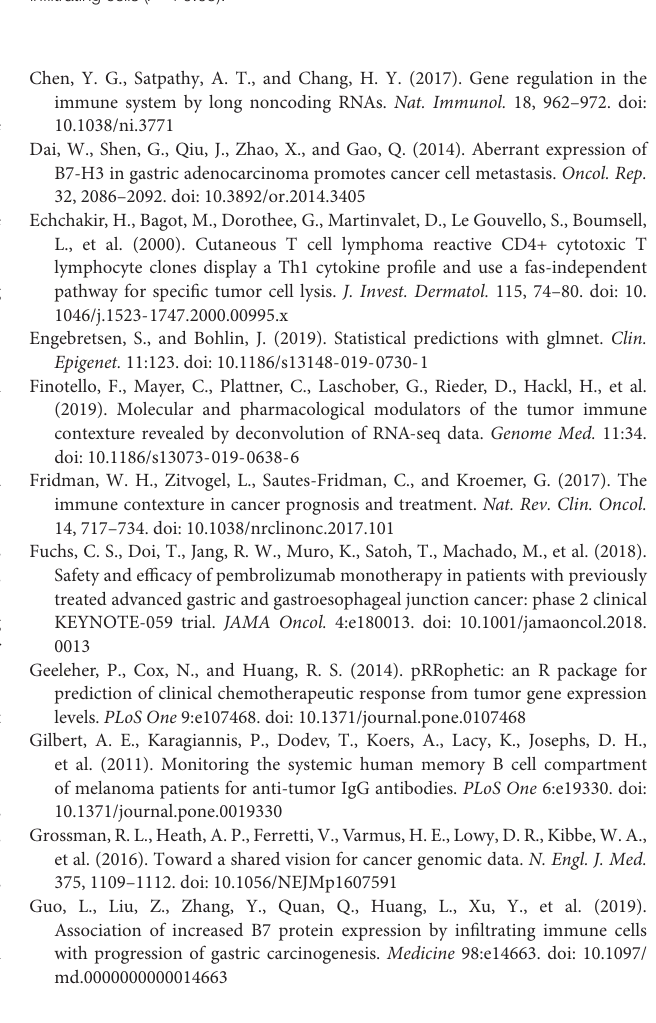
Supplementary Table 3 | The riskScore of each GC